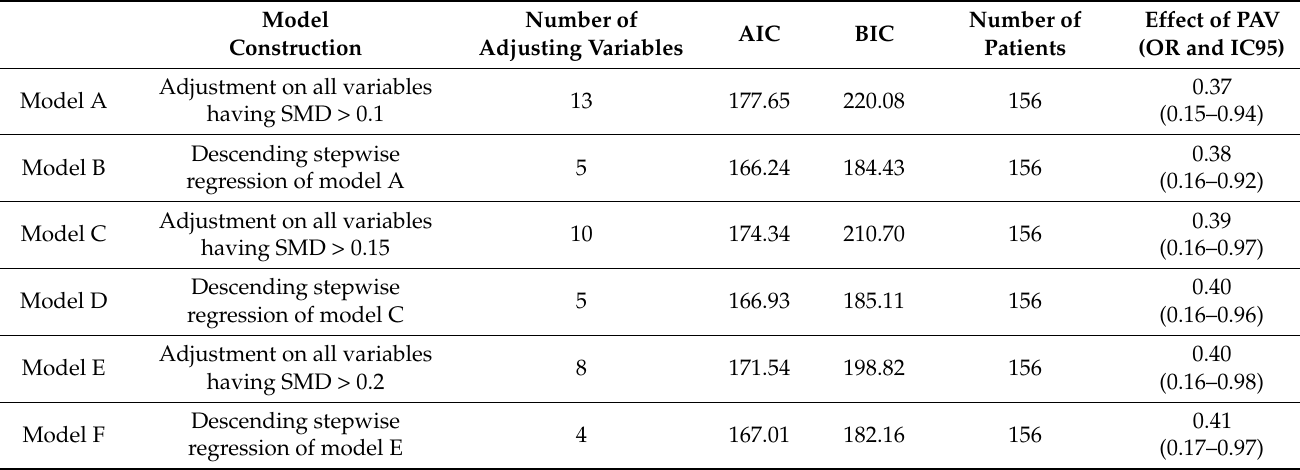
Table 5. Multivariate analysis. Table 5. multivariate analysis.